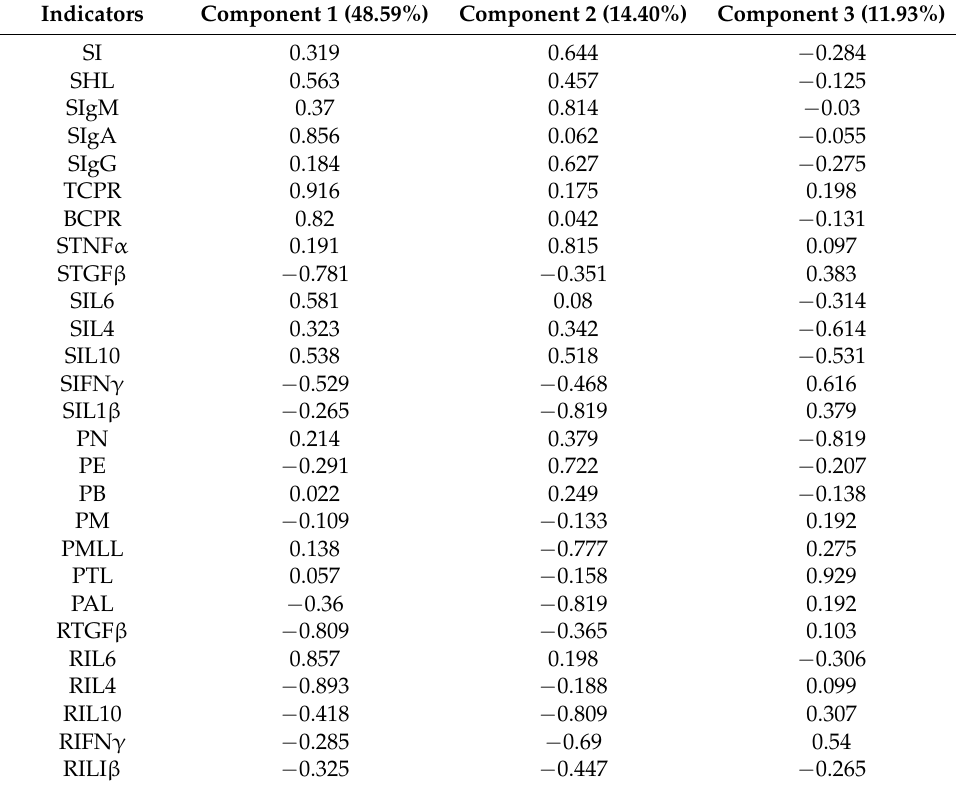
Table 4. The rotated component